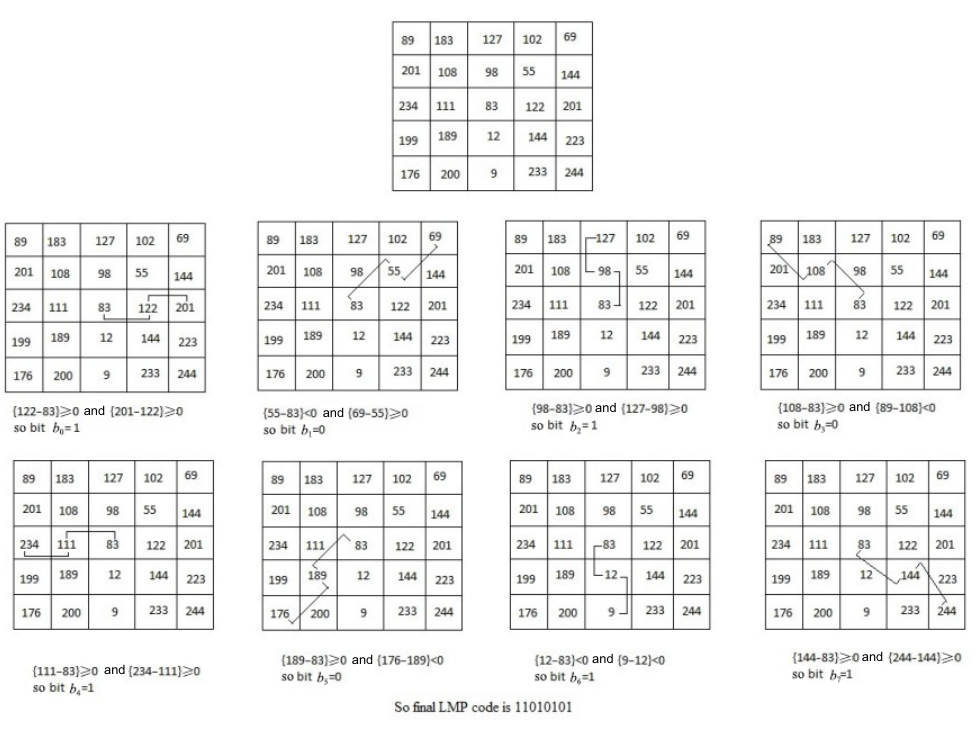
Fig. 5 LMP code generation procedure of the center